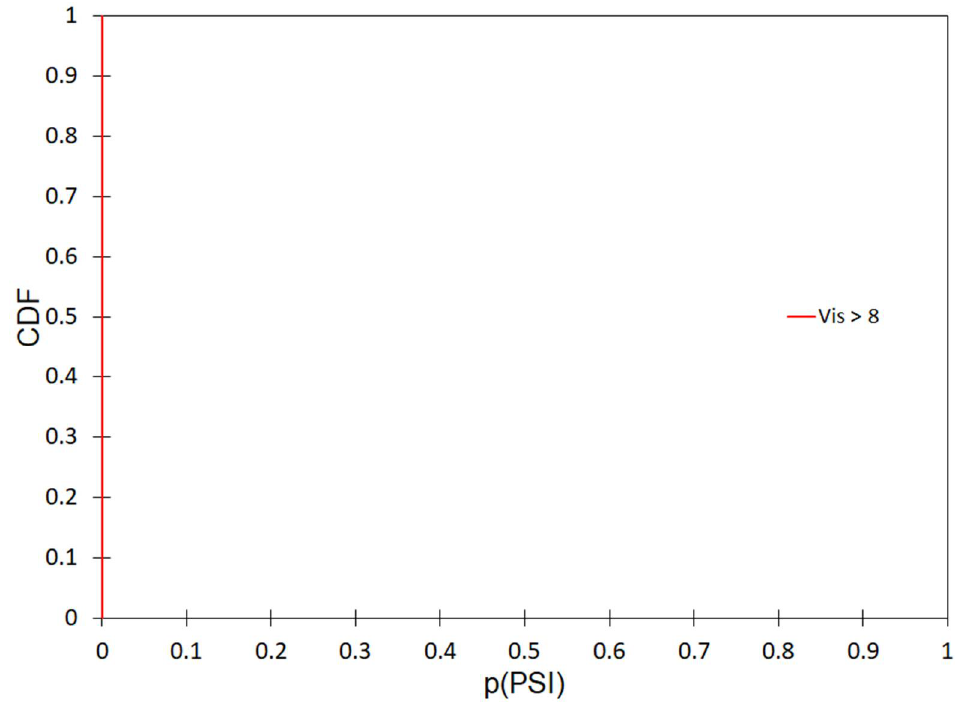
Figure A39. Effect of visibility on the incidence of very high spring mortality for rainy days.